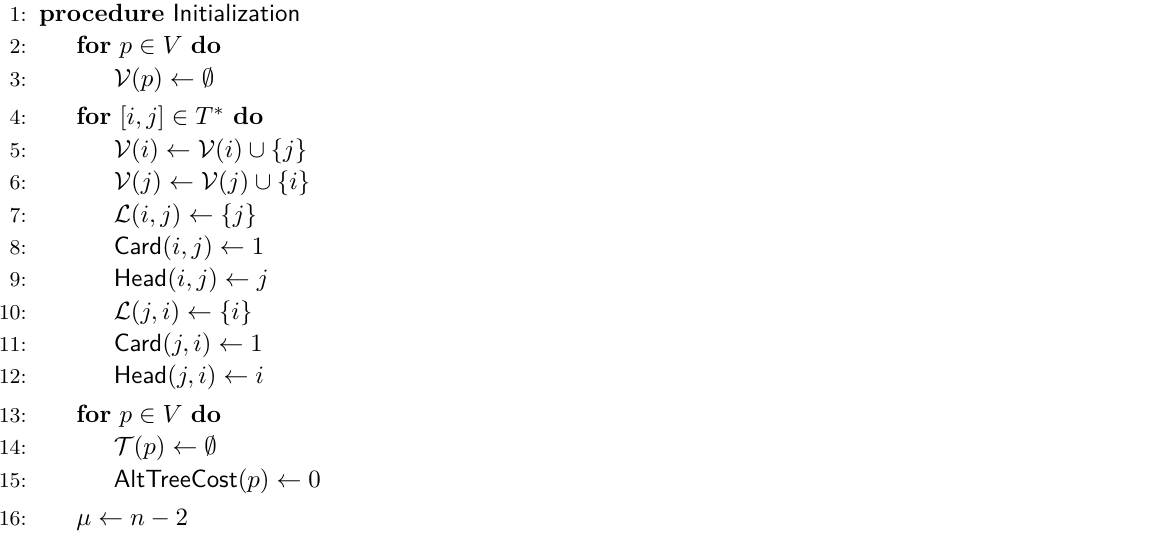
Algorithm 3 The procedure that initializes the local subgraphs.